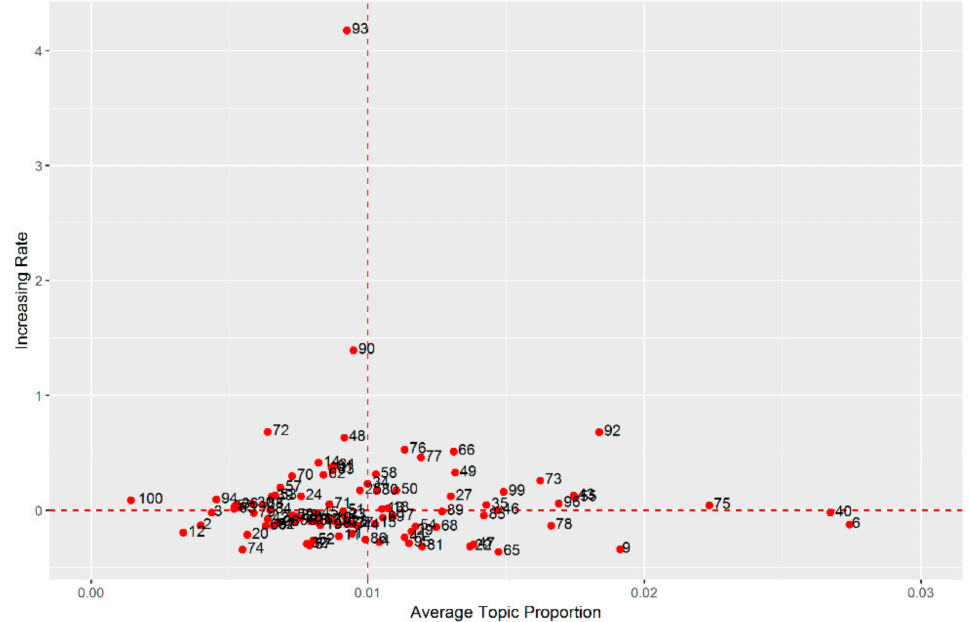
Figure 4. Placement of topics in the